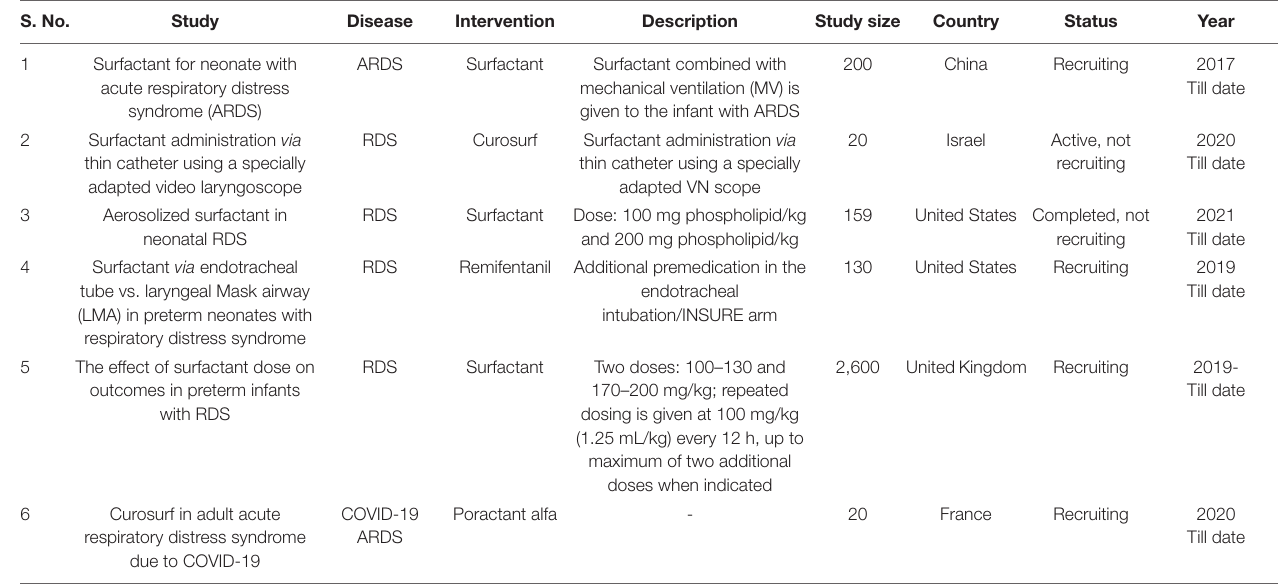
TABLE 1 | List of some of active and on-going clinical trials using surfactant compounds as a therapeutic agent against RDS/ARDS (Subramaniam et al., 2020). S.